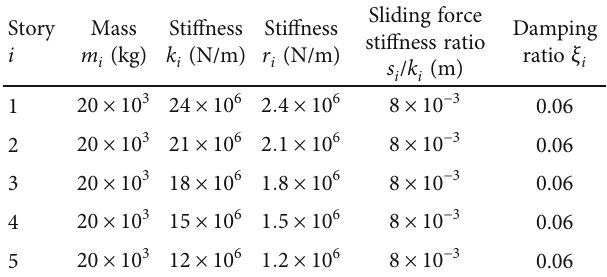
Table 4: Means of the random system properties.